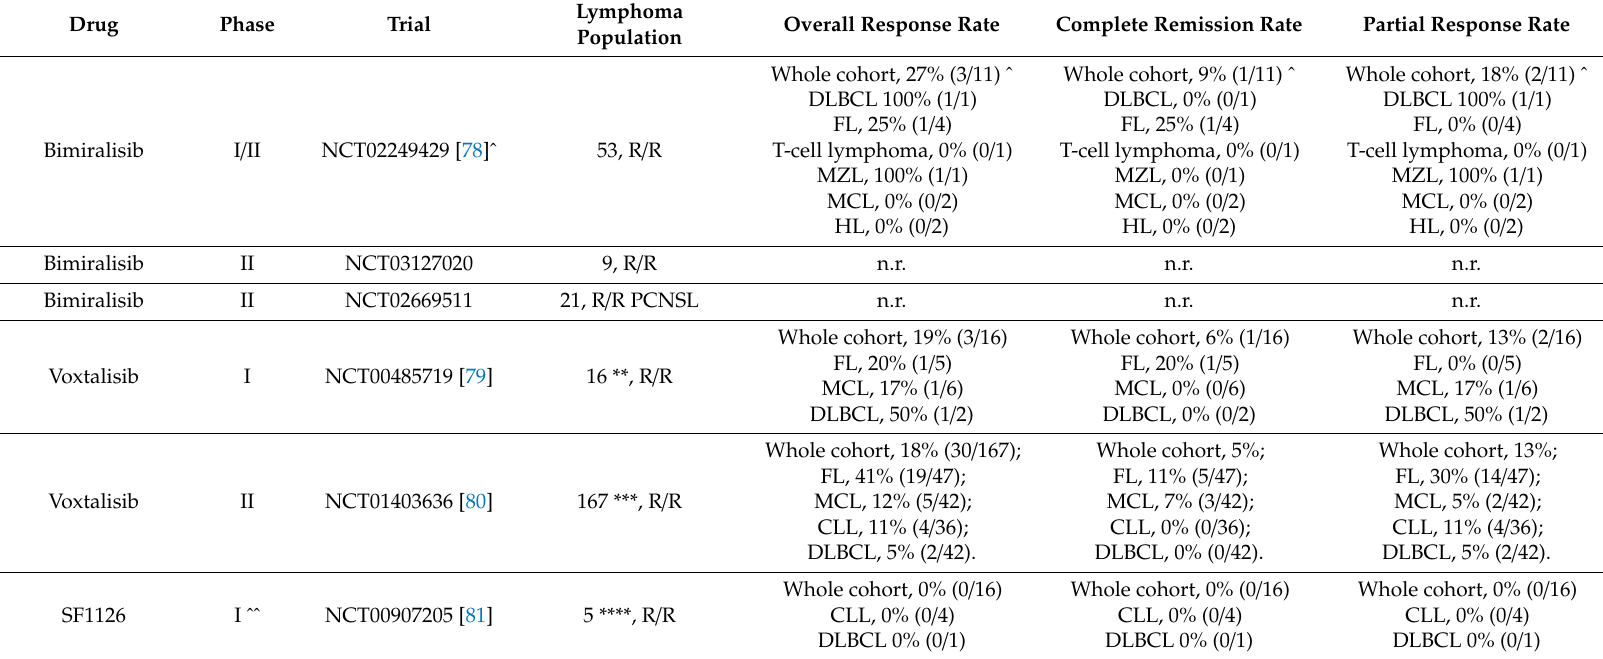
Table 2. Clinical trials evaluating dual PI3K / mTOR inhibitors as single agents that have enrolled lymphoma patients